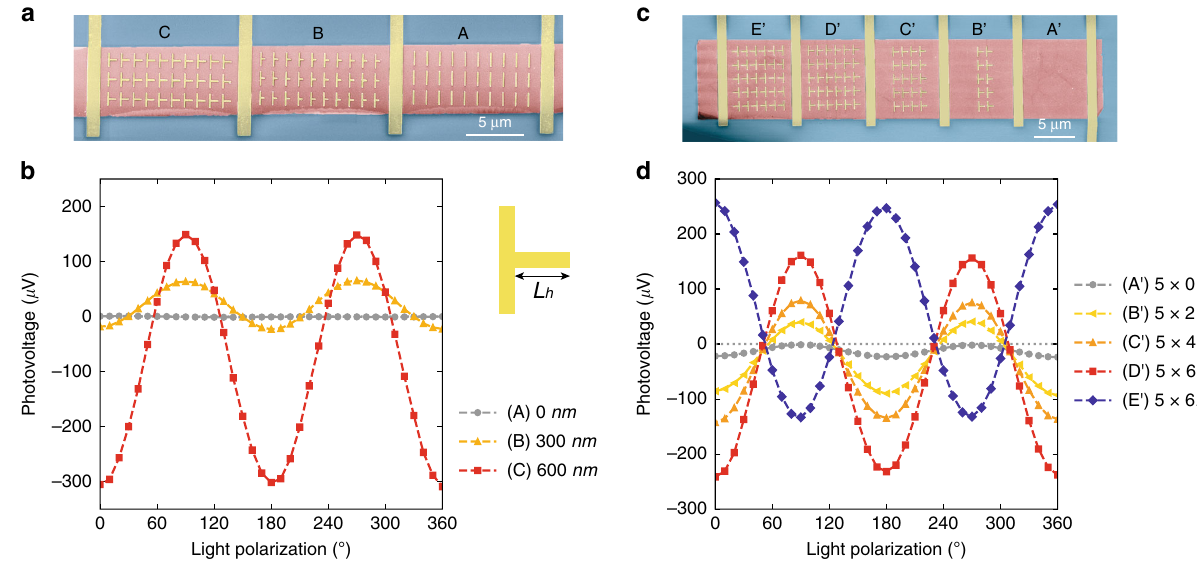
Fig. 2 Evidence of bulk photoresponse. a , b SEM images and measured photovoltage of three devices with different degrees of asymmetry. When the lengths of horizontal arms ( L h ) decrease from device C to A , the photoresponse decreases and vanishes eventually due to the absence of broken symmetry. c , d SEM images and measured photovoltage of fi ve devices with different numbers of nanoantennas, where the nanoantennas closest to the contact electrodes are removed gradually from Device D ′ to A ′ . Device E ′ has the same number of nanoantennas as device D ′ , but the orientation of nanoantennas is reversed. The photovoltages is only dependent on the number of nanoantennas but insensitive to their position. The non-zero photoresponse of device A ′ could be due to non-uniform illumination, fabrication imperfections or nonlocal photoresponse from neighboring devices. Error bars are smaller than the size of markers. Dashed lines are guides to the